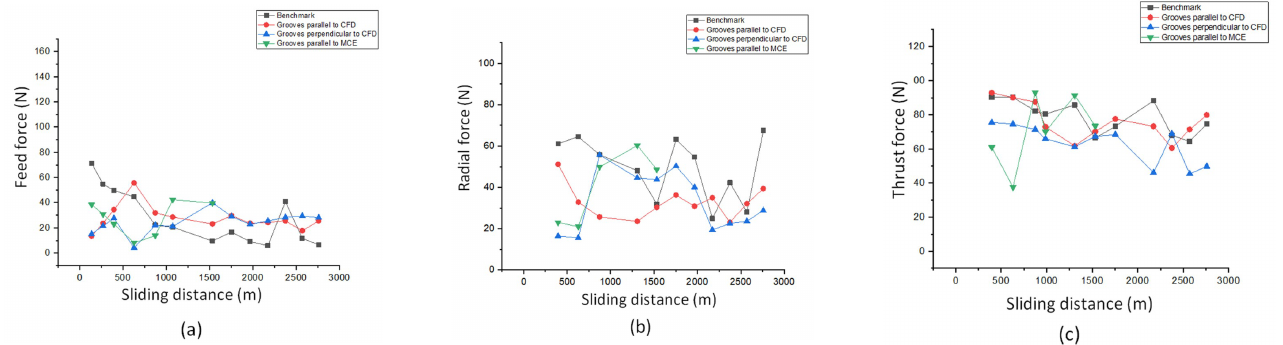
Figure 19. Comparison of the acquired forces while using textured tools and a benchmark cutting tool: ( a ) feed force; ( b ) radial force and; ( c ) thrust force [80].